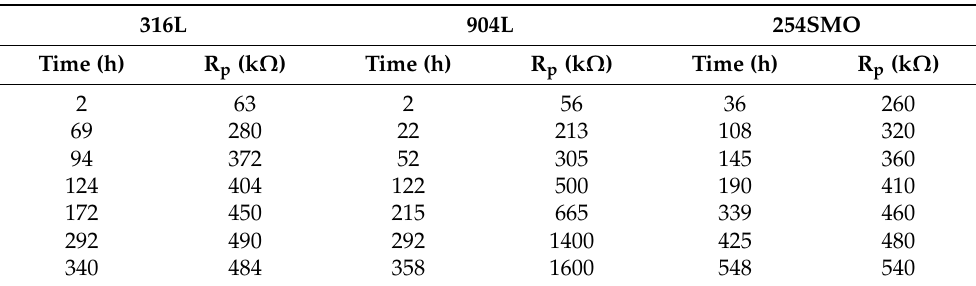
Table 4. Dependence of polarization resistance (Rp) on exposure time [28]. Copyright Wiley-VCH GmbH. Reproduced with